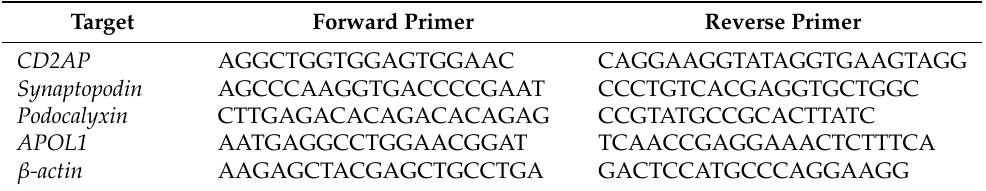
Table 1. Primer sequences used for gene expression analyses in quantitative